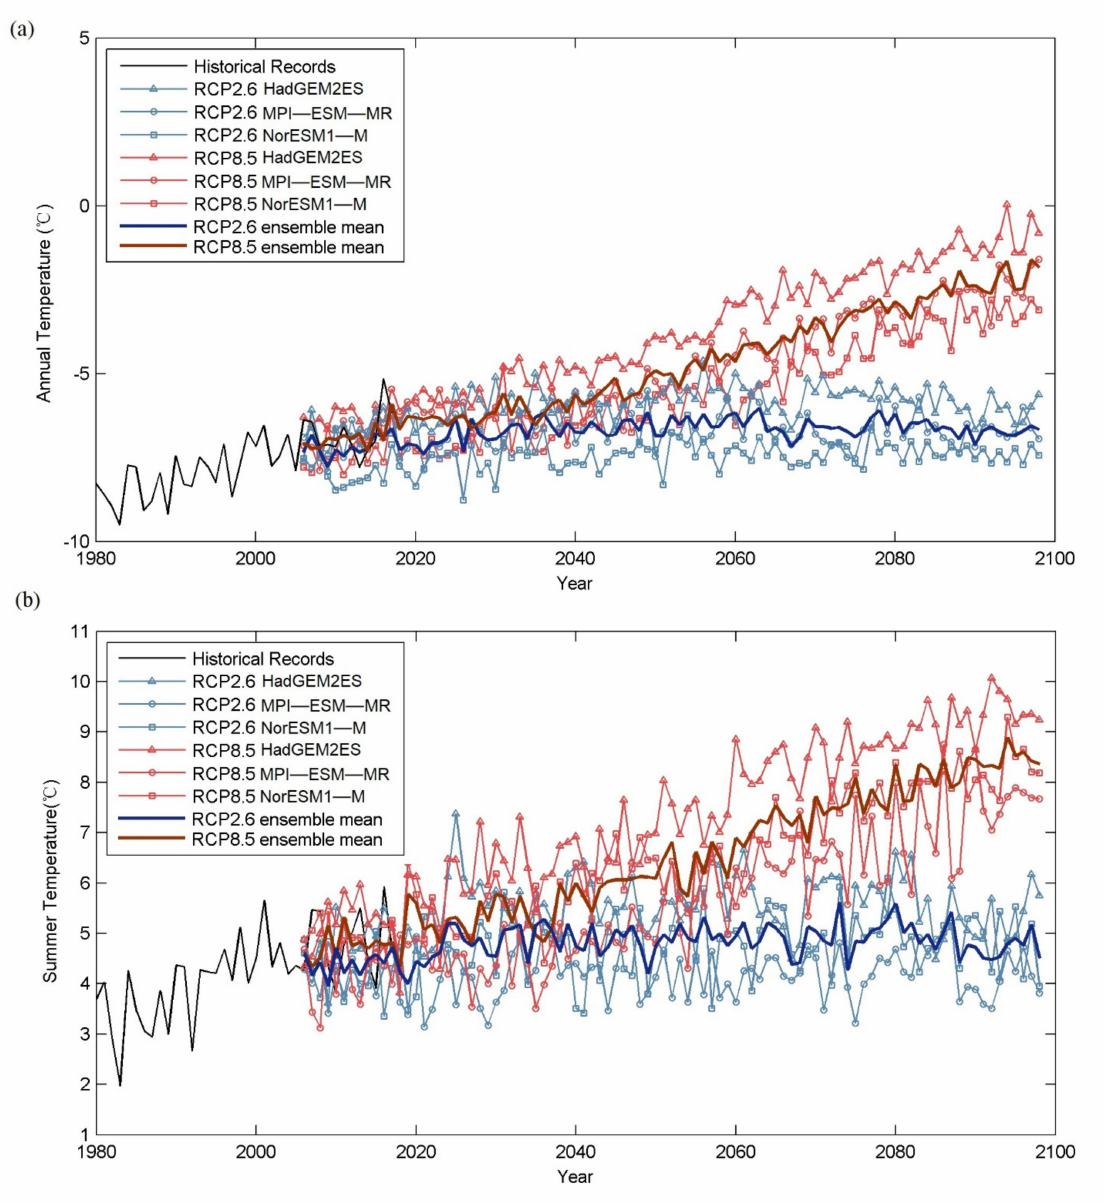
Figure 9. Historical annual mean temperature ( a ) and summer mean temperature ( b ) at the elevation of AWS from Shiquanhe station from 1980 to 2017 (black), and the future annual mean temperature projected by RegCM4 under RCP2.6 (blue) and RCP8.5 (red) from 2006 to 2098 driven by 3 ESMs (HadGEM2ES, MPI − ESM − MR, NorESM1 − M). Thick lines represent ensemble